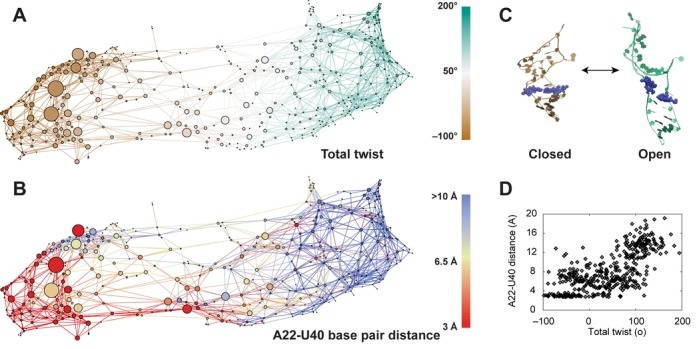
The physical basis of the observed partitioning of the configuration space network of TAR. (A) The configuration space network of TAR colored to show the total twist (αh + γh) of each node. Each node in the network represents a given (αh, βh, γh) conformation and the links between nodes show the transitions between conformations. (B) The nodes are colored to show the A22-U40 base pair distance within each conformation. All nodes with distances greater than 10 Å are colored blue. (C) Representative conformations of the two network partitions, which we label ‘closed’ and ‘open’ for the left and right partition, respectively. The A22 and U40 bases are shown in van der Waals representation. (D) Scatter plot showing the A22-U40 distance versus the total twist for each node. Color figure is available online.